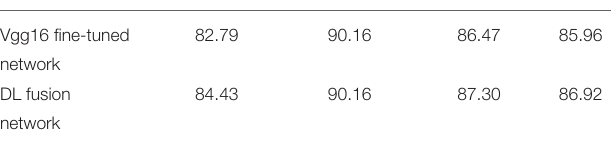
TABLE 4 | Classification performance of Vgg16 fine-tuned network and DL fusion